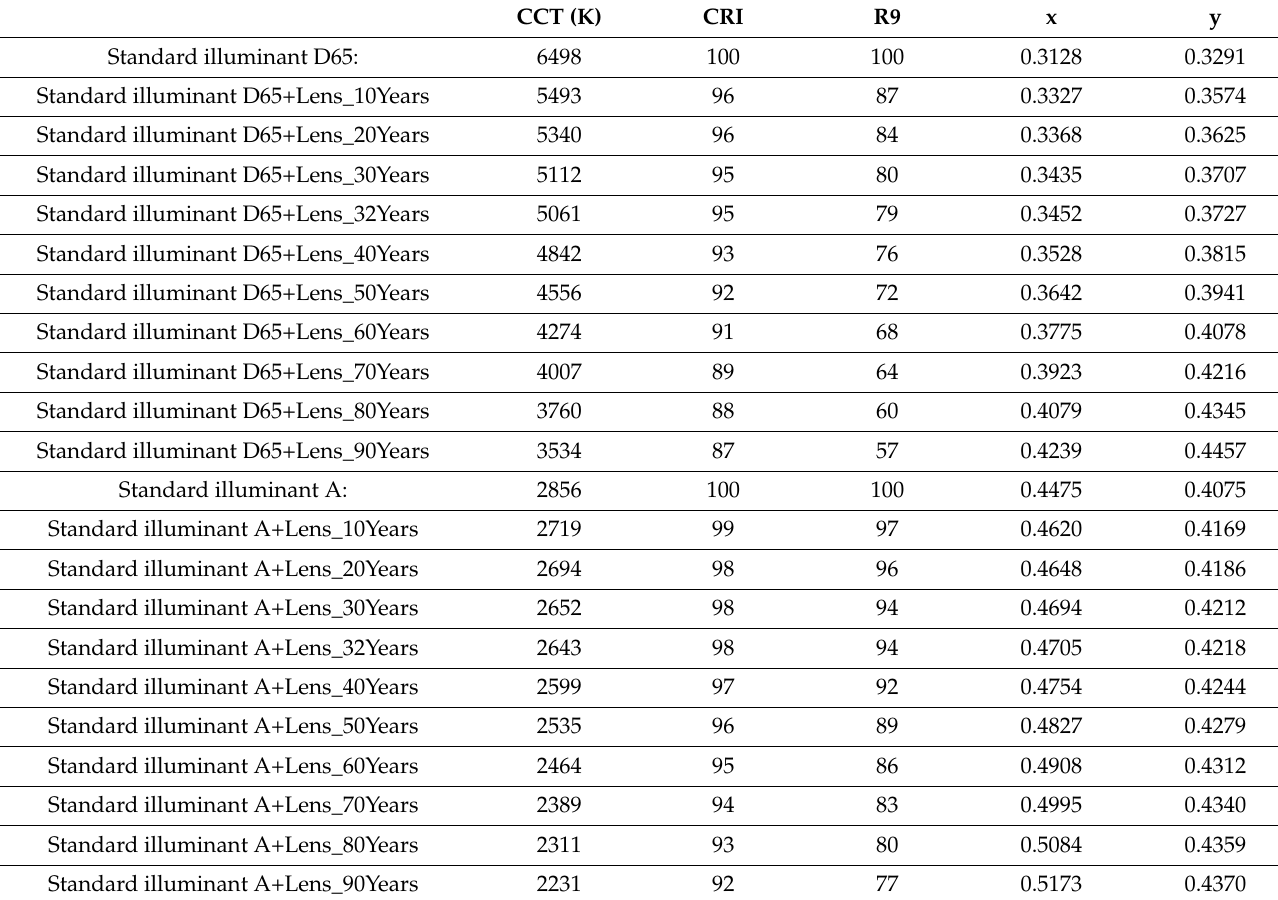
Table 1. D65 and A standard illuminants apparent photometric characteristics modified by crystalline lens transmittance, or perceived by retina, depending on age, from 10 to 90-year-old observers. Ab- breviations: CCT, Correlated Color Temperature; CRI, Chromatic Rendering Index; R9, saturated